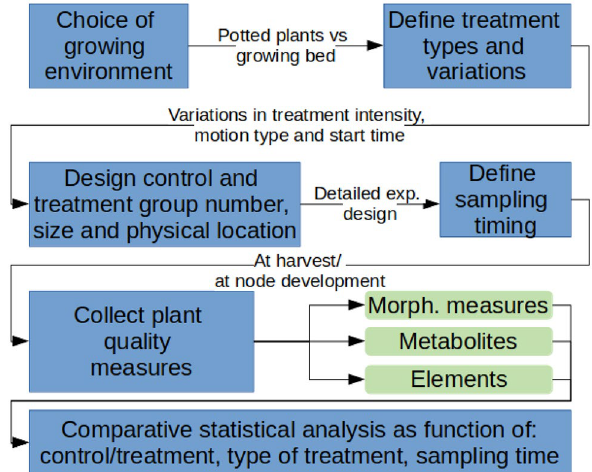
Figure 3. Overall evaluation protocol for mechanical stress using the robotic systems developed, and the illustrative experiment design outlined in Experiments 1–3.